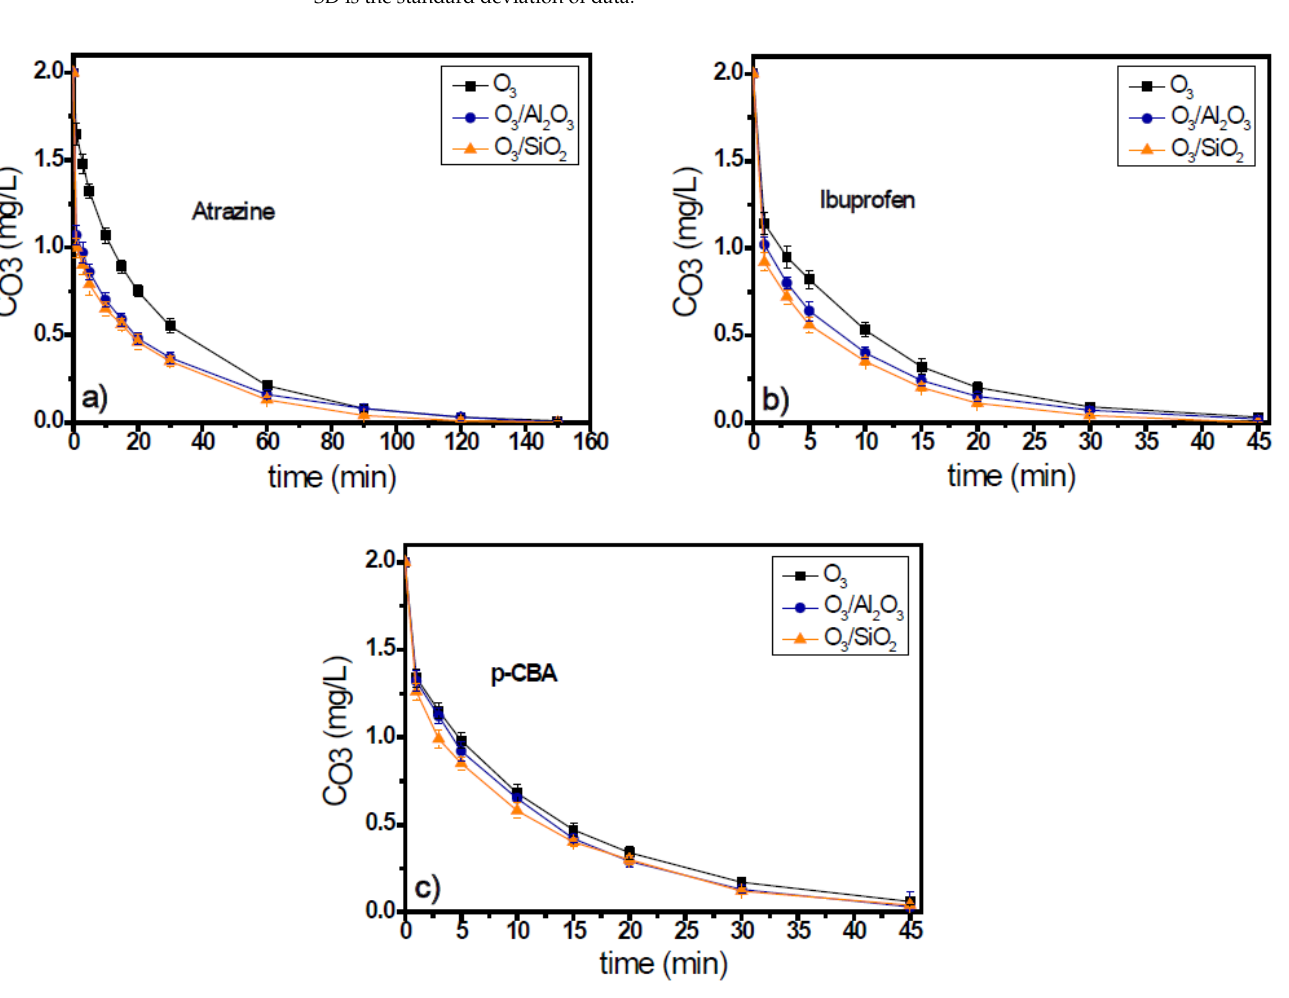
Figure 1. Ozone decomposition during catalytic ozonation of ( a ) atrazine, ( b ) ibuprofen, and ( c ) p- CBA with the use of Al 2 O 3 and SiO 2 as catalysts compared to single ozonation in natural potable water. Experimental conditions: C MP 500 μg/L, C cat. 0.5 g/L, C O3 2 mg/L, pH 7.8, T 23 ± 2 °C. Table 3. Adsorption capacity of Al 2 O 3 and SiO 2 materials for the examined micropollutants, pre- Paracetamol presented a higher adsorption for both examined solid materials during senting different physicochemical properties. Experimental conditions: C micr. 500 μg/L, C cat. 0.5 g/L, the first 20 min of the adsorption process. The efficiency of examined solids was similar pH 7.8, T 23 ± 2 °C.